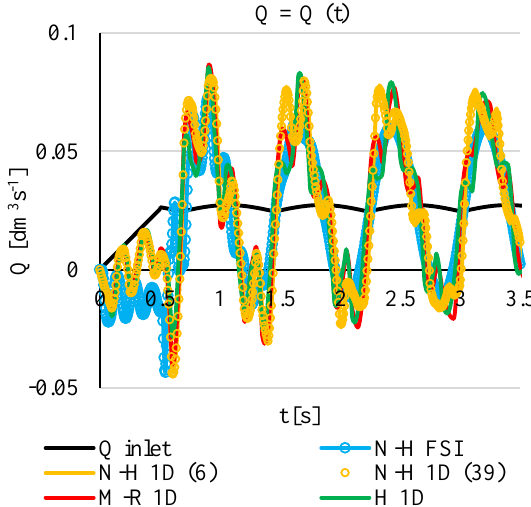
Fig. 19. Volumetric flow rates Q in thick-walled